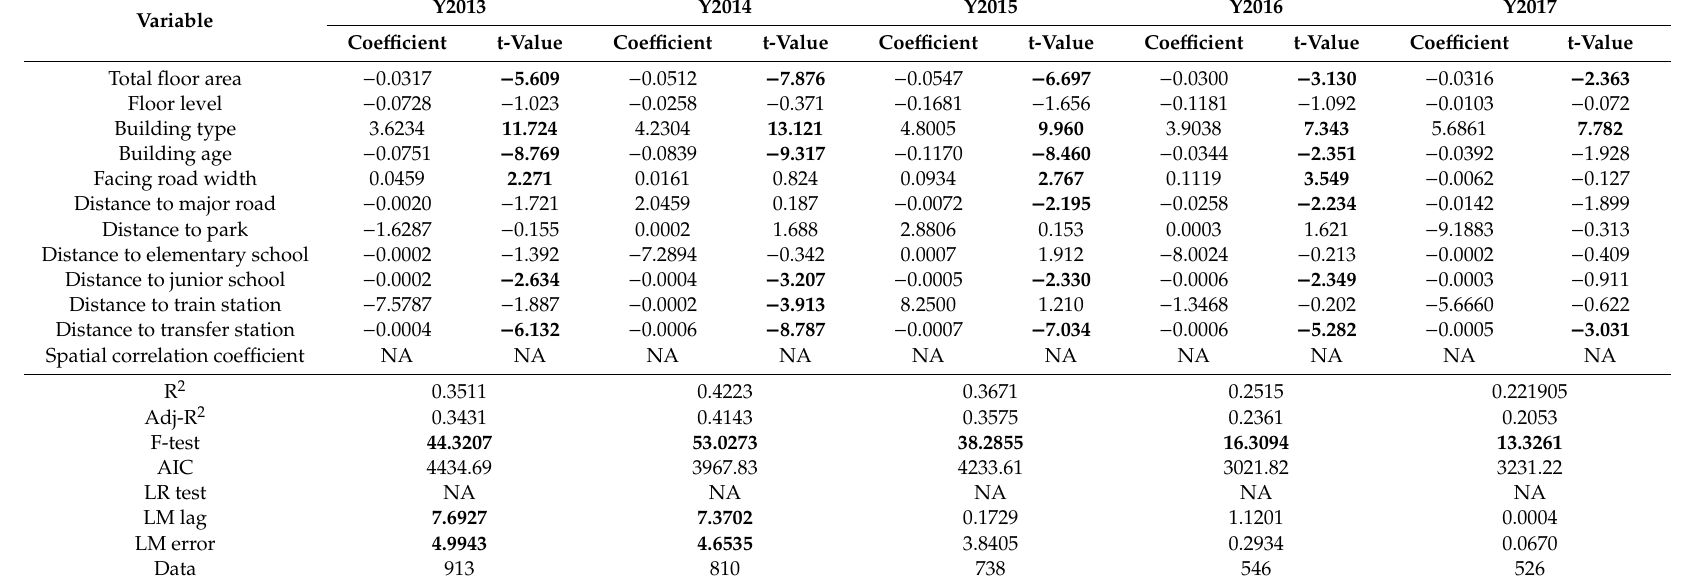
Table 2. The analysis results between 2013 and 2017 by the hedonic price